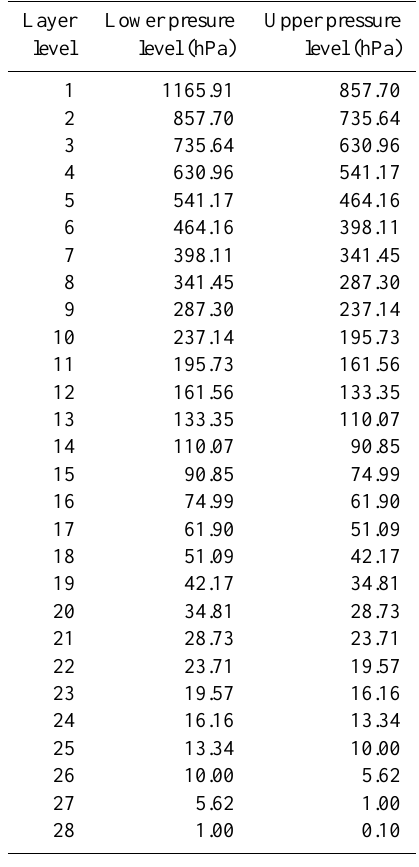
Table 1. Retrieval grid layers of GOSAT/TANSO-FTS TIR CO 2 V1 data.